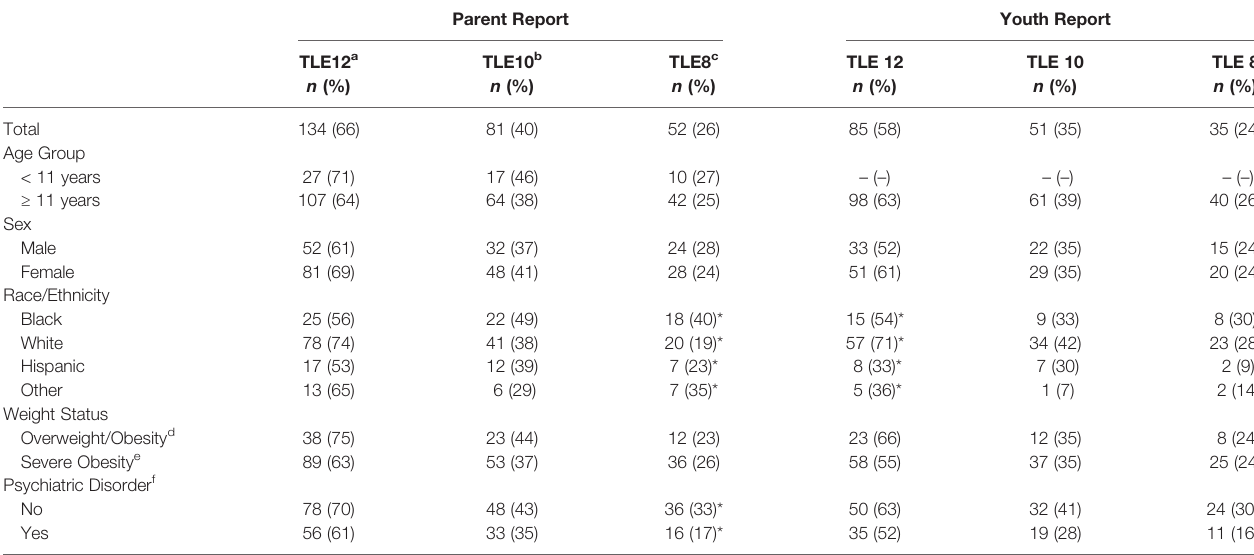
TABLE 2 | Parent and youth interest in time-limited eating of different lengths in total and grouped by patient characteristics.